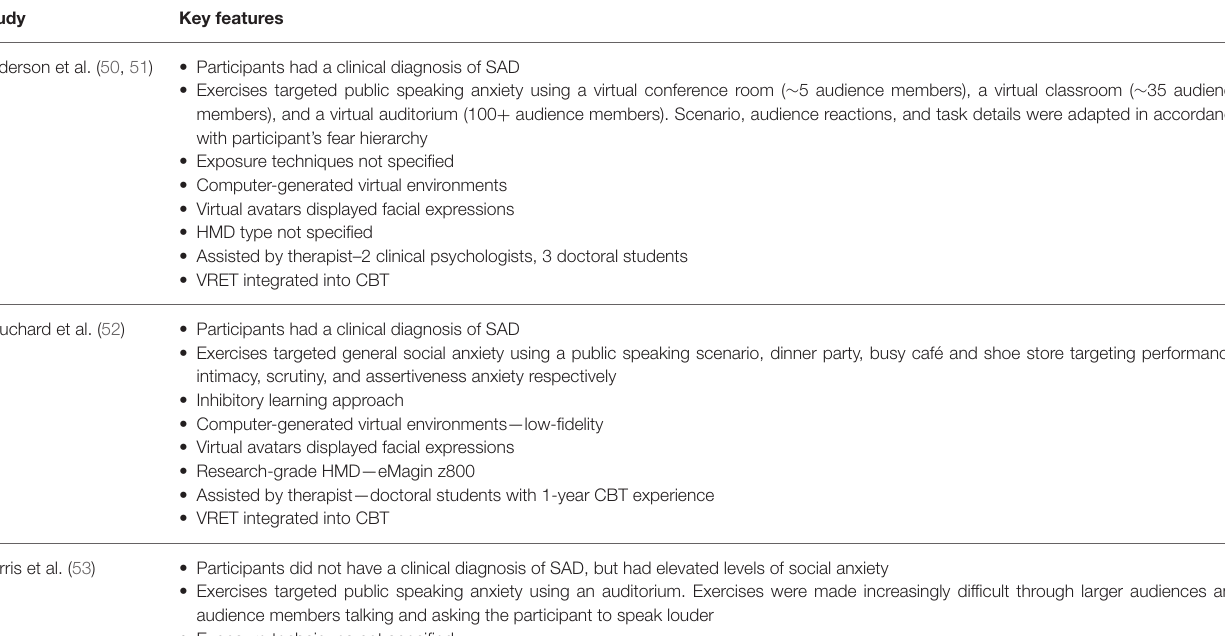
TABLE 2 | Key features of studies included in the scoping review. Key